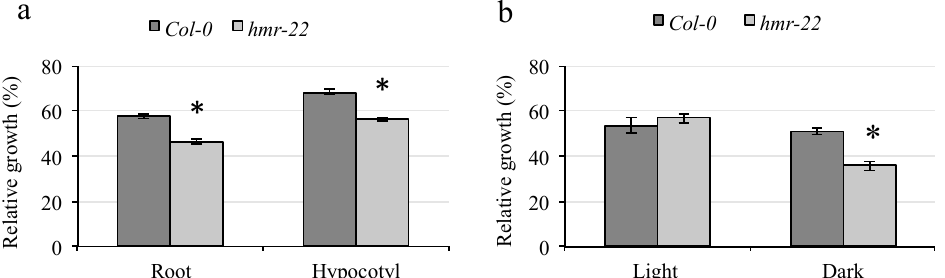
Figure 4. Yeast two-hybrid analysis of RAD4–HMR interaction. HEMERA (HMR) interacted with both full-length RAD4 and the RAD4 N-terminal half. Five-fold dilutions of the indicated diploid strains were plated on the double drop-out (–leu, –trp) control plate on the left, and the quadruple drop-out (–leu, –trp, –ade, –his) selection medium on the right. The interaction between p53 and T, resulting in growth on the selective medium, is the positive control, whereas Lam and T, which do not interact, are the negative control.